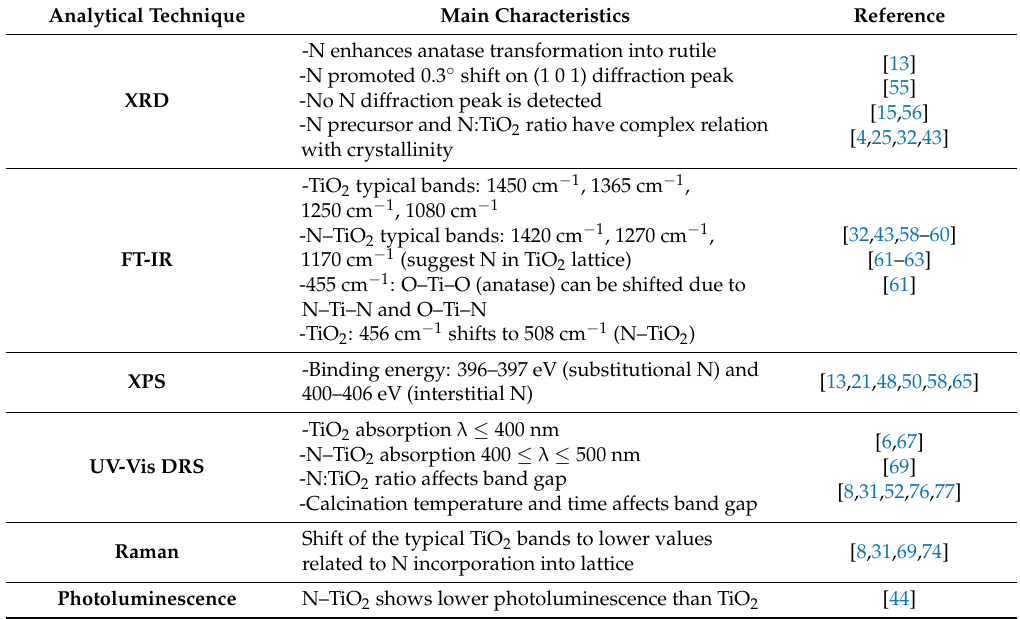
Table 2. Main changes identified through different characterization techniques due to N incorporation in TiO 2